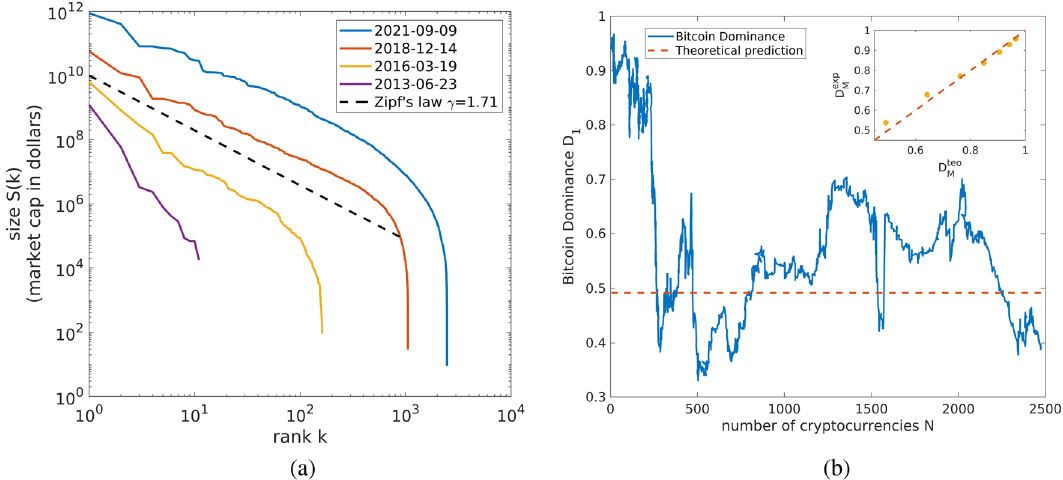
Figure 1. ( a ) Rank-size plots. Evolution of the rank-size plot of the cryptocurrency market over time. The black dashed line represents the expected trend corresponding to the average Zipf’s power law distribution exponent γ ≈ 1.71 . ( b ) Dominance of Bitcoin. The Bitcoin dominance is displayed as function of time with the red dashed line showing the asymptotic dominance derived from Zipf’s exponent. Note how the dominance fluctuates around its theoretical estimated value. The inset shows a comparison between the empirical dominance of the first M = 1, 2, 4, 8, 16, 32, 64 coins and the theoretical values; the red dashed line is the bisector of the quadrant. By considering a larger number of cryptocurrencies, the noise is attenuated and the adherence between theory and empirical data improves. Figures created with Matlab R2021a https:// it. mathw orks. com/ produ cts/ matlab.